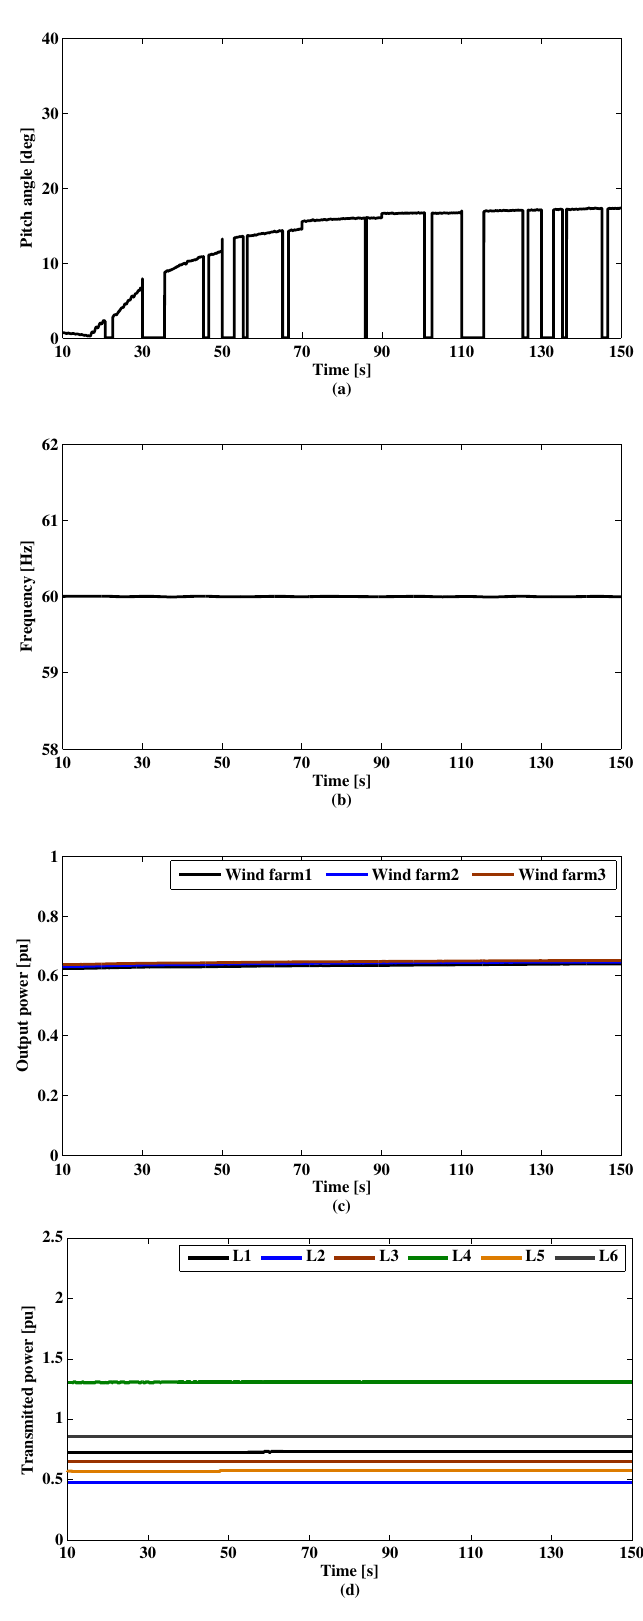
Figure 12. Case 3 result. ( a ) Pitch angle. ( b ) System frequency. ( c ) Generated output power of wind farms. ( d ) Transmitted